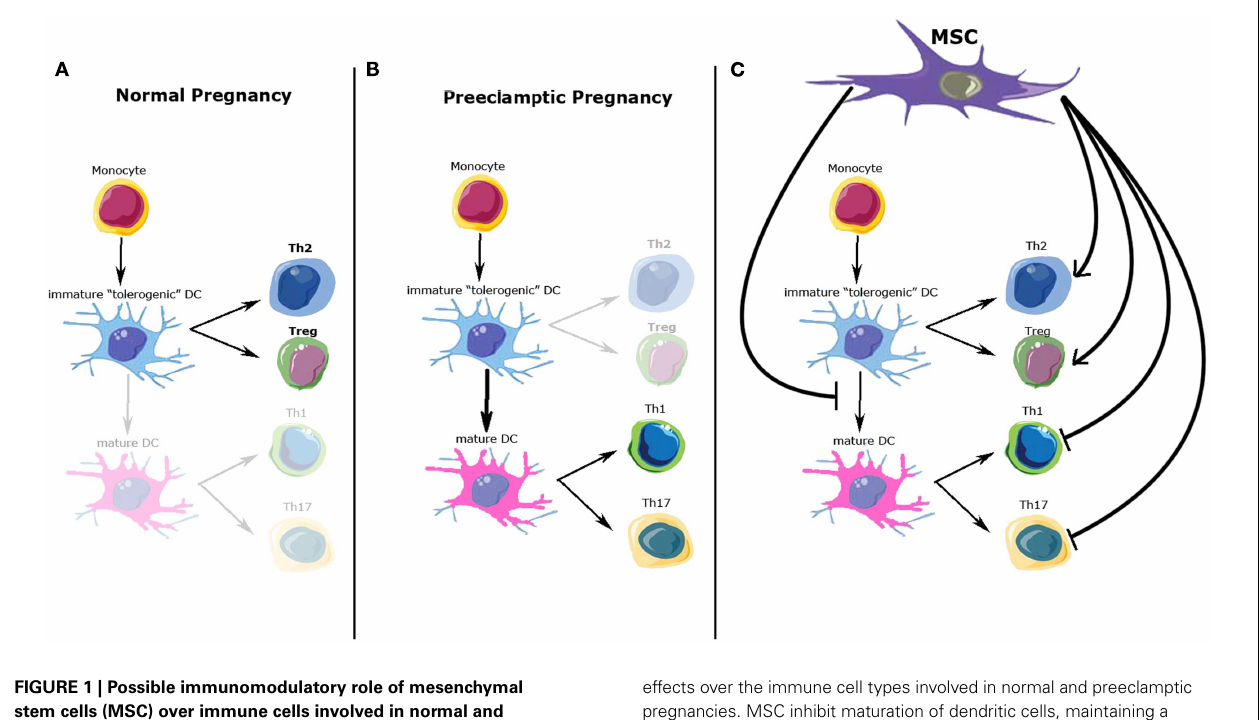
FIGURE 1 | Possible immunomodulatory role of mesenchymal stem cells (MSC) over immune cells involved in normal and preeclamptic pregnancy . (A) Normal pregnancy is considered as a Th2 type immunological state, whereTh2 CD4 + T-cells andTreg cells response and cytokine profile predominate. (B) On the other hand, preeclamptic pregnancies have been considered as a maternal pro-inflammatory state withTh1/Th17 predominance. (C) Possible MSC